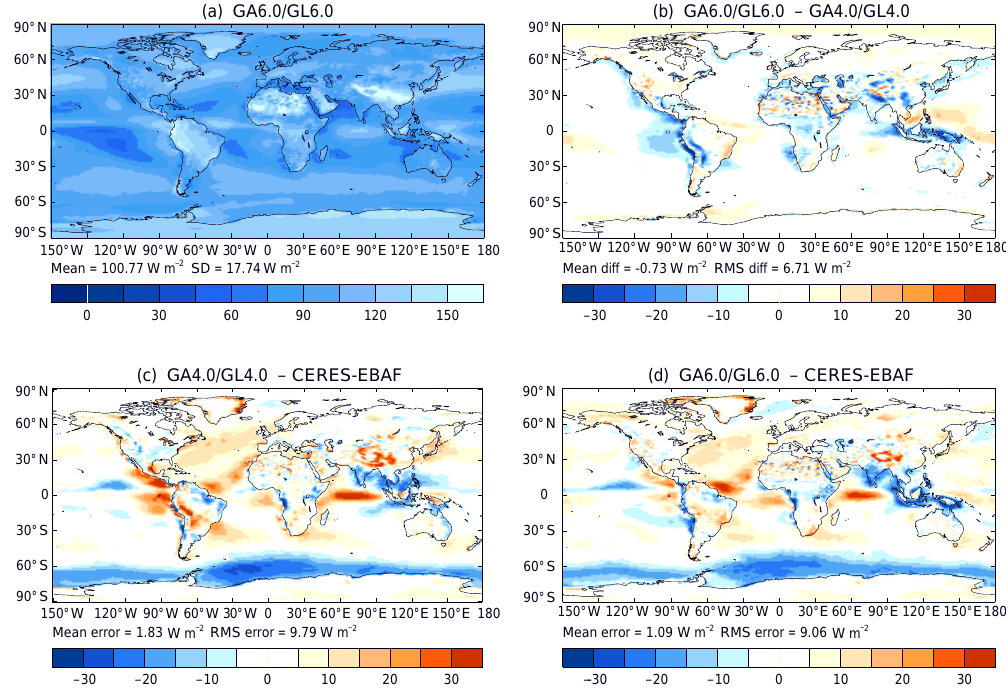
Figure 17. Top of atmosphere reflected shortwave radiation (Wm − 2 ) in N96 atmosphere/land-only climate simulations of GA6.0 and GA4.0 compared with CERES EBAF (Clouds and the Earth’s Radiant Energy System – Energy Balanced and Filled dataset; Loeb et al., 2009). The layout is the same as in Fig.